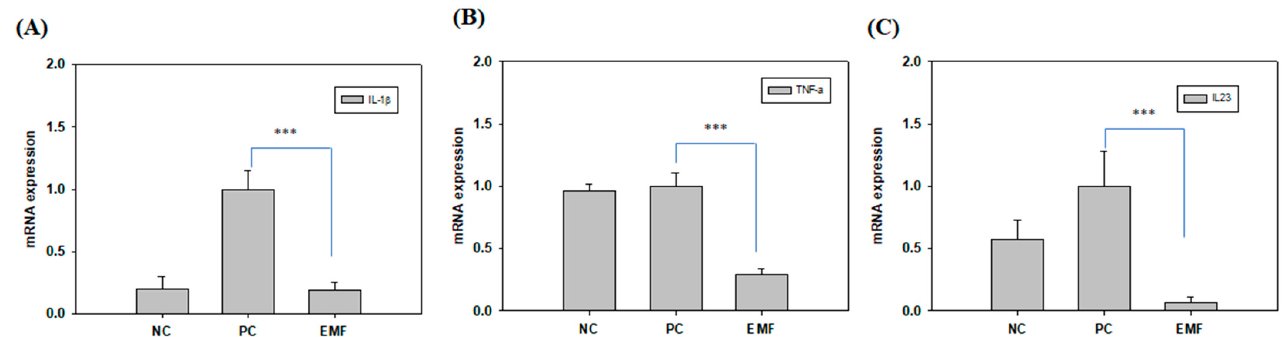
Figure 5. EMF-induced changes in cytokine expression. Expression levels of ( A ) IL-1 β , ( B ) TNF- α , and ( C ) IL-23 were determined by RT-qPCR in Raw 264.7 cells differentiated for 4 days in differ- entiation media (with RANKL) with or without EMF exposure. NC, cells grown in growth media (undifferentiated); PC, cells grown in differentiation media (with RANKL); EMF, cells grown in differ- entiation media (with RANKL) with EMF exposure. The symbol *** indicates significant differences with p < 0.005.